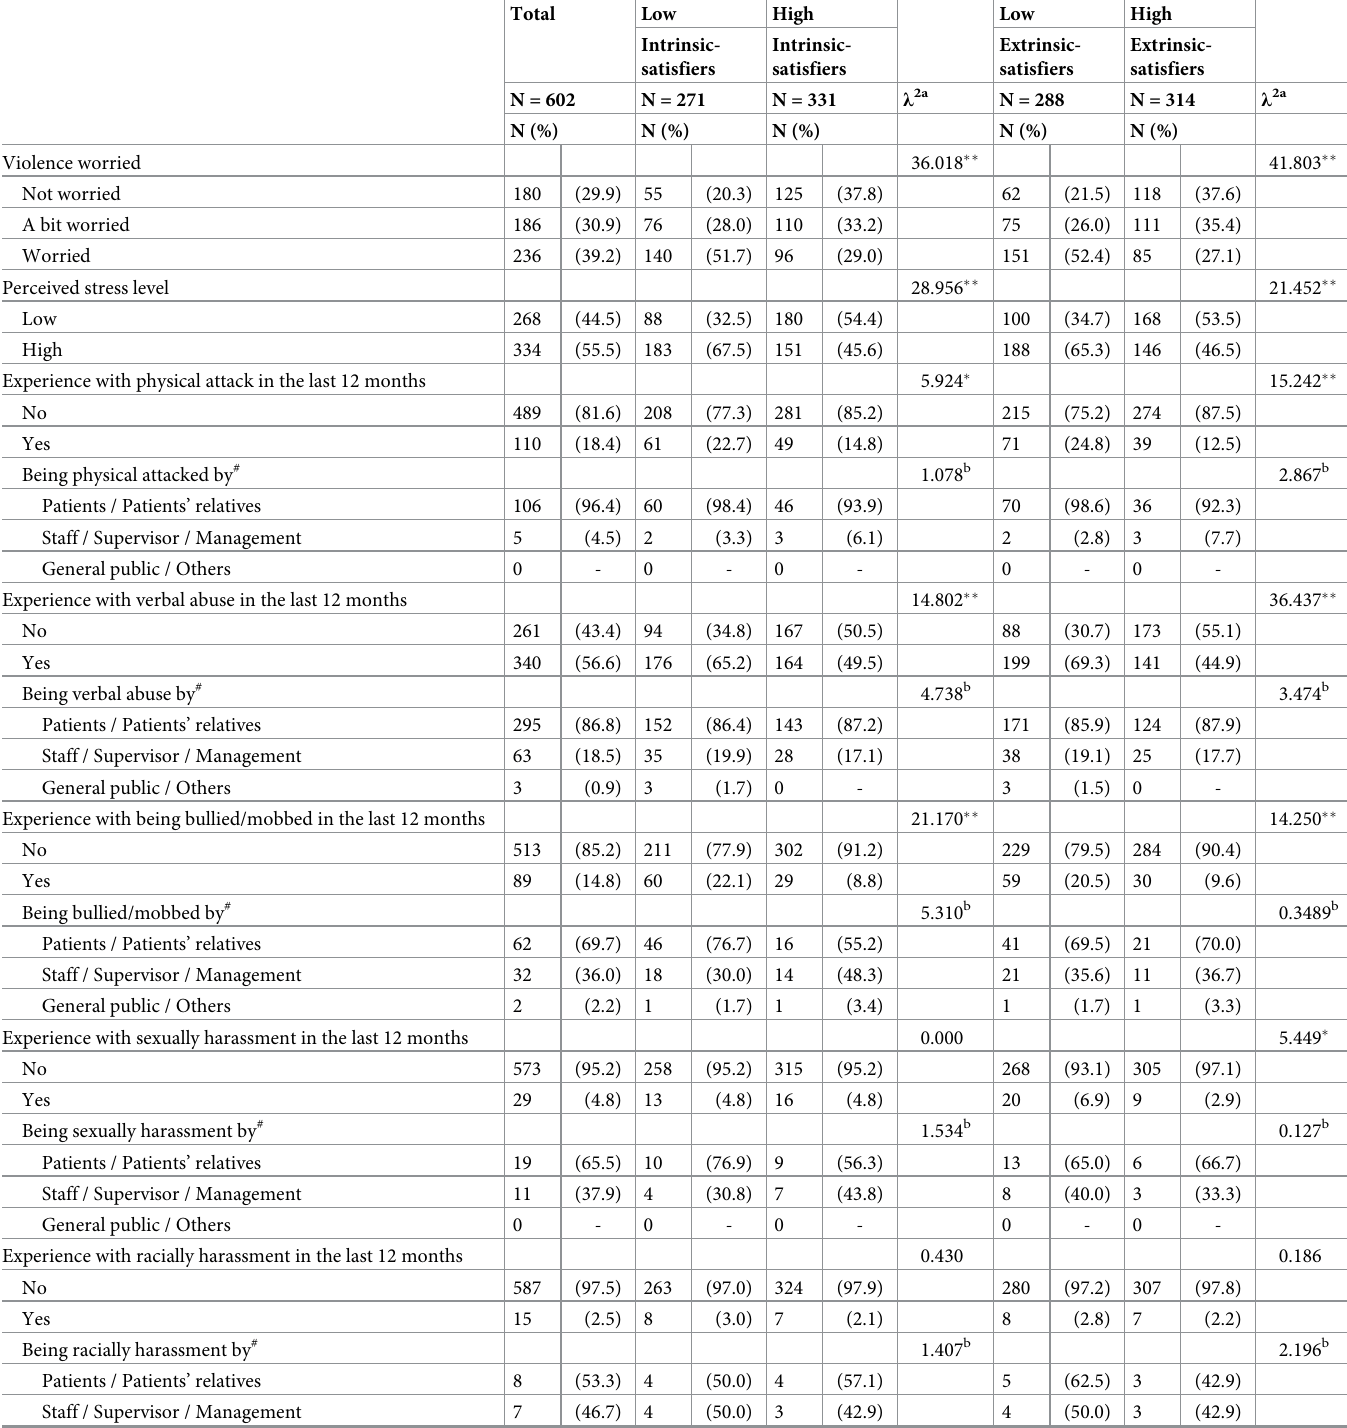
Table 4. Worry about WPV, perceived stress and experience with WPV—Nurses.